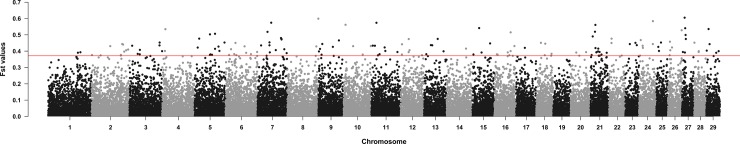
Manhattan plot of the Fst values for each single nucleotide polymorphism (SNP).Chromosomes are alternately colored in black and grey. Red line corresponds to the 0.995 of the percentile distribution (Fst = 0.372).